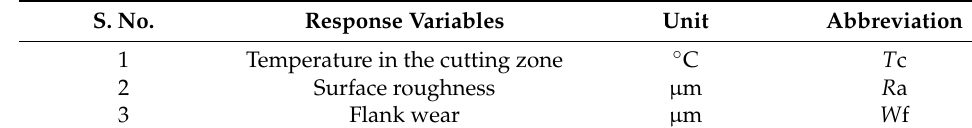
Table 3. Selected response variables.